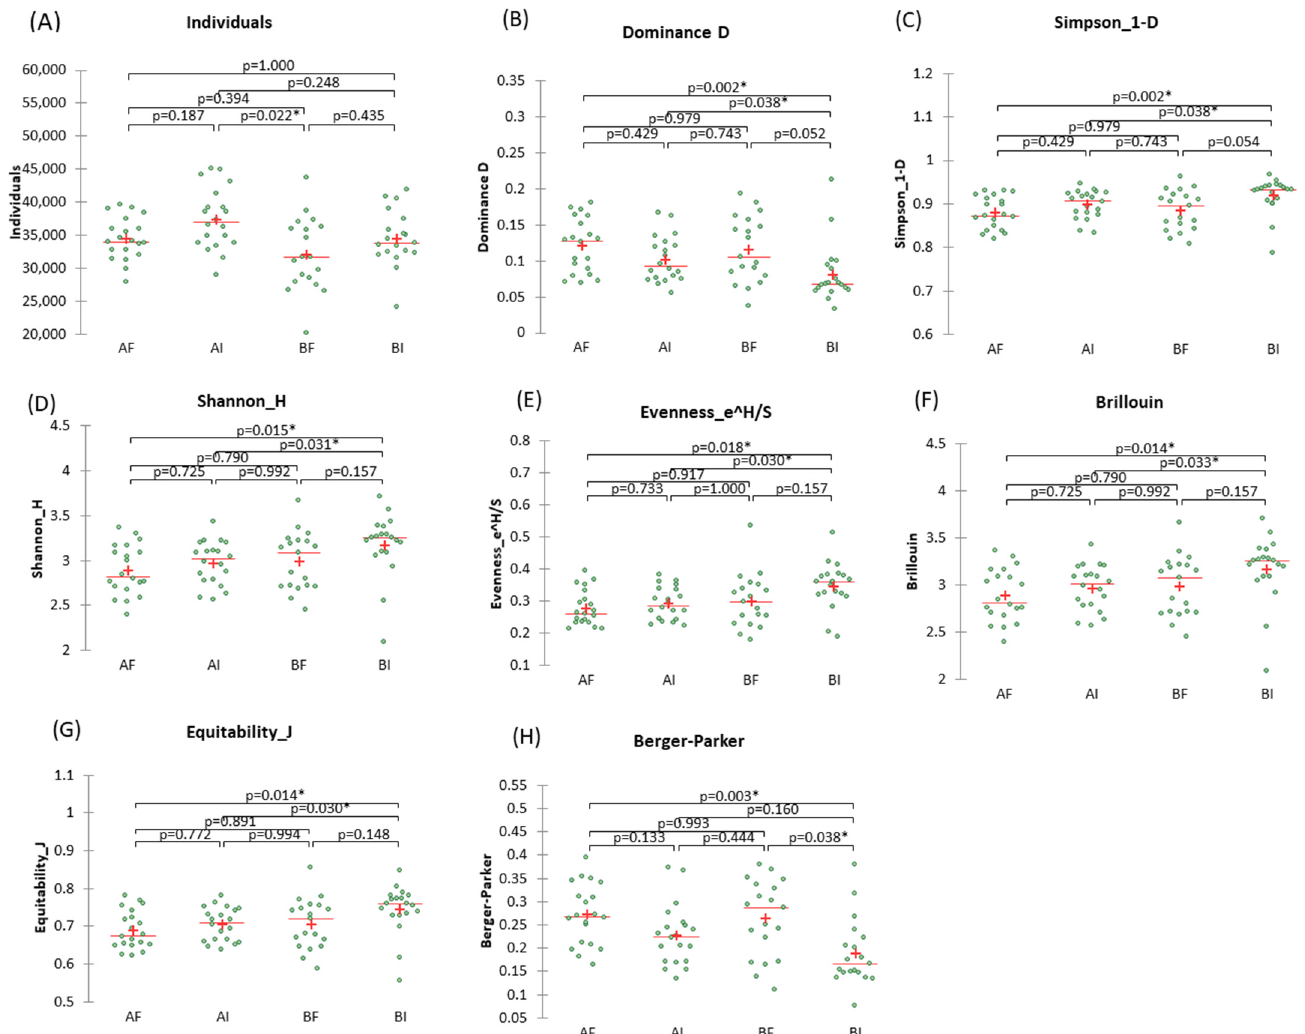
Figure 2. Dispersigrams of the alpha-diversity indices obtained in the randomised, placebo-controlled, single-blind trial to study the effect of oral L. pentosus LPG1 on the human gut microbiota. According to the Kruskal-Wallis test, at least one significant difference between treatments (AI, AF, BI, and BF for their respective groups and trial phases) was obtained. Notably, there are significant differences between the initial and final stages in the Group B—placebo, according to Berger-Parker (at p < 0.05) and Dominance D and Simpson 1-D indices (at p < 0.10). * stands for significant differences.